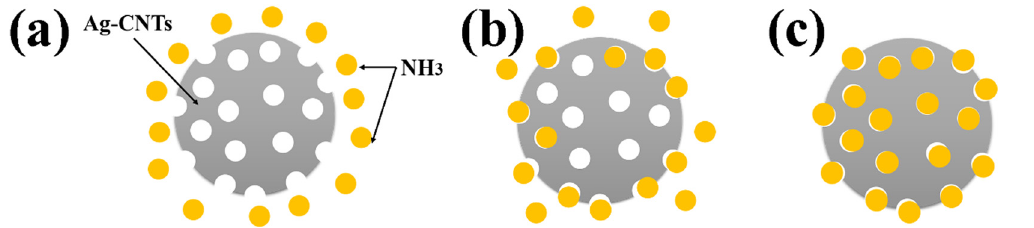
Figure 5: Process of adsorption of NH 3 by Ag - CNFs. ( a ) Ag - CNFs in NH 3 atmosphere. ( b ) Ag - CNFs begin to adsorb NH 3 and surface seepage occurs. ( c ) Surface adsorption is saturated and begins to di ff use internally.